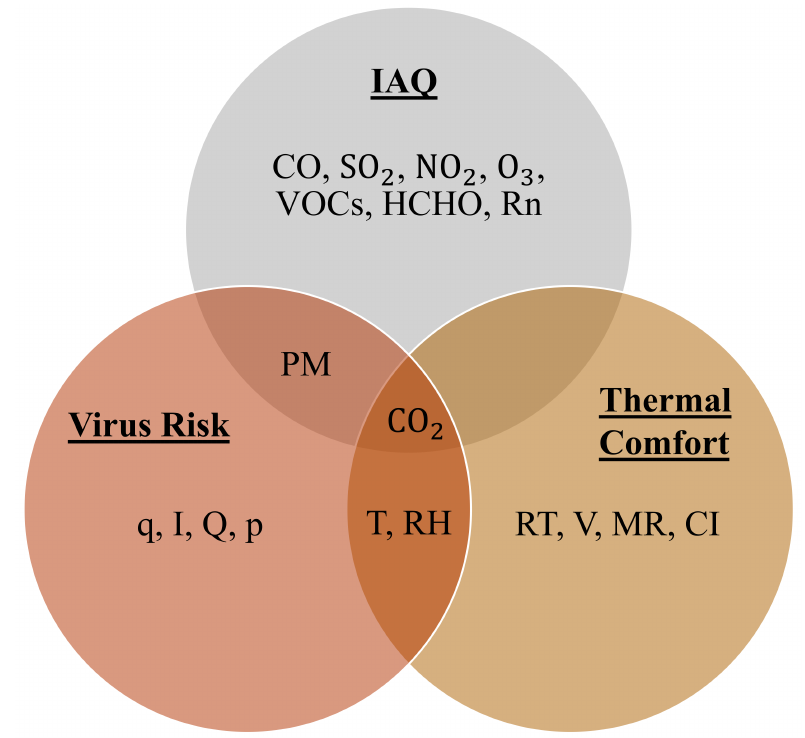
Figure 4. Parameters linked with IAQ, thermal comfort and virus